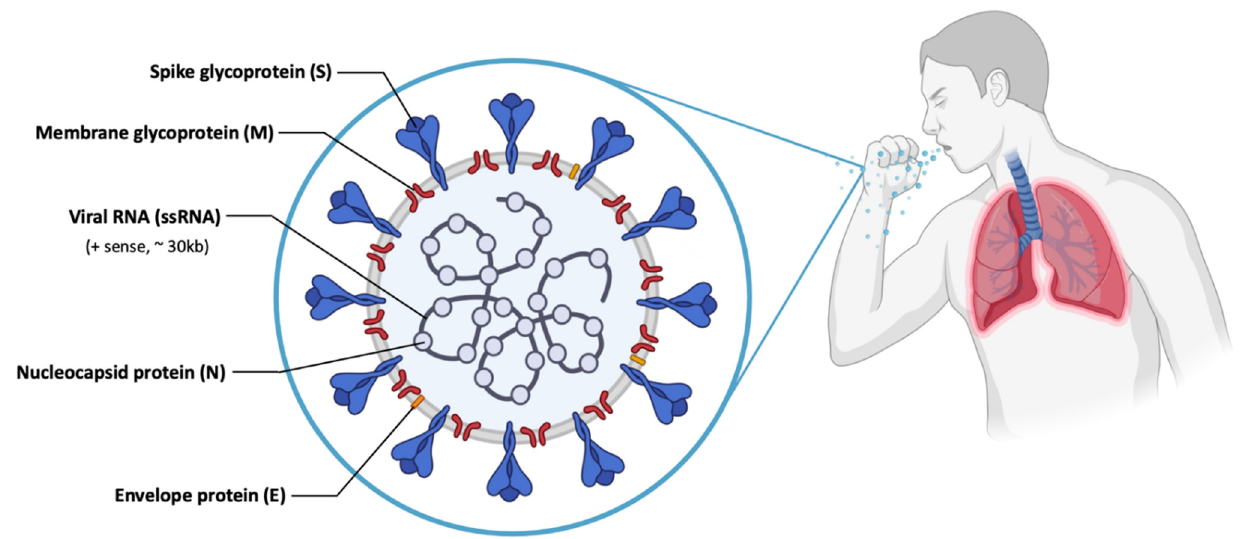
Figure 7. Scheme of the structure of SARS-CoV-2, with different viral proteins indicated. The S glycoprotein is part of the outer layer of the virus and is essential for its entry into cells [118]. This protein consists of a receptor binding domain (RBD), that is responsible for specific binding to the angiotensin-converting enzyme 2 (ACE2) receptor, thus allowing the entry of SARS-CoV-2 [114] in the epithelium cells of human lung [119]. In addition, there are studies that indicate that SARS-CoV-2, as well as SARS-CoV, can enter the cell through clathrin-mediated endocytosis [115]. Of all structural proteins, it was found that S glycoprotein induces neutralizing antibodies and it was the main target antigen for the development of the vaccines